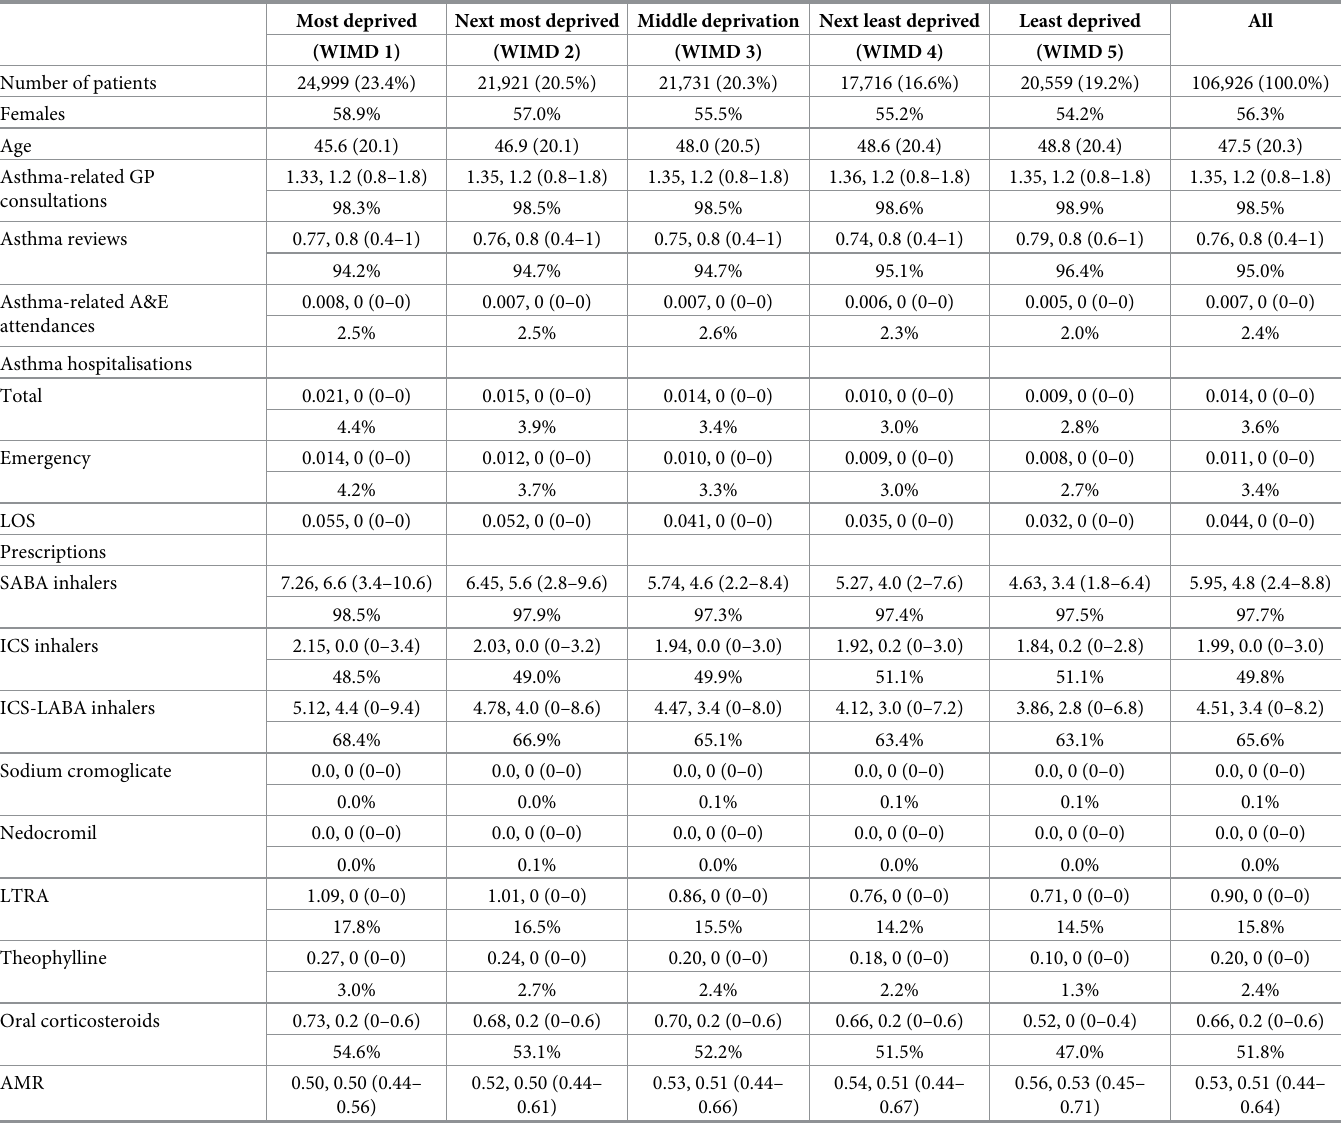
Table 2. Characteristics of the study